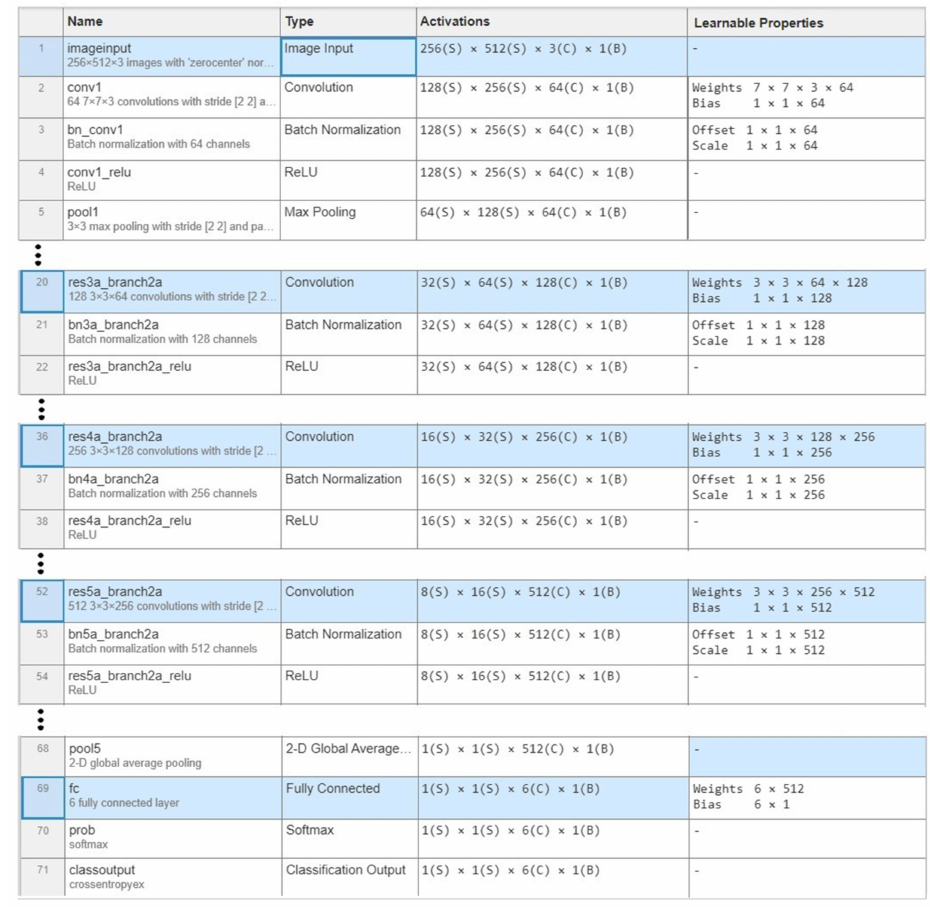
Figure 17. Layer structure analysis for the CNN model training.